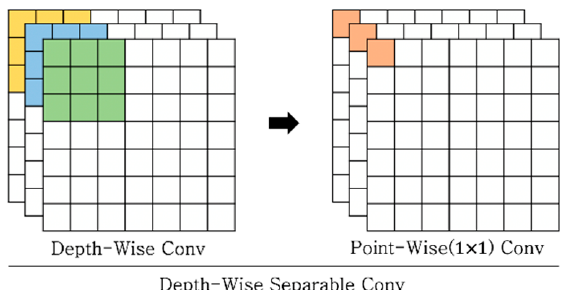
Figure 4. Depthwise separable convolution. Each channel performs convolution using an independent kernel, which is referred to as depthwise convolution. Pointwise convolution is then performed with a 1 × 1 kernel.